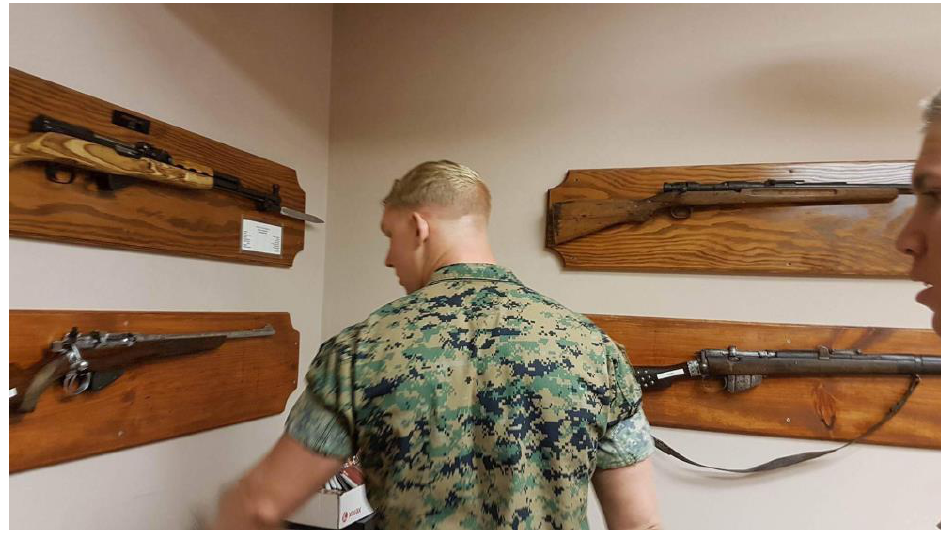
Jezabeth Roca Gonzalez, Gringolandia , 2017-2018, Photograph.